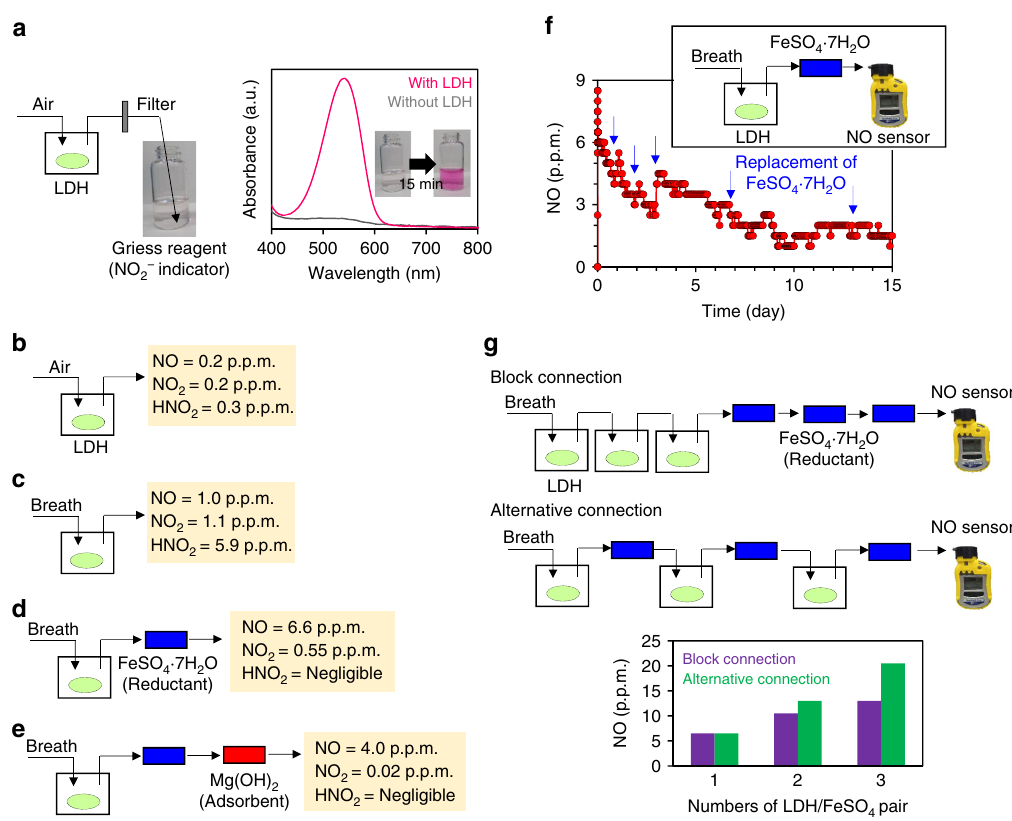
Fig. 4 Release of HNO 2 and conversion to NO. a Color change of Griess reagent showing the presence of HNO 2 . b – e Concentrations of NO, NO 2 , and HNO 2 released from 100 mg NaNO 2 -Mg/Al(3/1) (determined by detector tube). See Supplementary Fig. 3 for experimental details. Air (20 °C, 35%RH) or exhaled breath were applied at fl ow rate of 100 mL min − 1 . Released gases were passed through FeSO 4 ∙ 7H 2 O and Mg(OH) 2 loaded in the glass tube. f NO- release pro fi le from 100 mg NaNO 2 -Mg/Al(3/1) under exhaled-breath fl ow (50 mL min − 1 ). FeSO 4 ∙ 7H 2 O was occasionally replaced with new ones (indicated by blue arrow). See Supplementary Fig. 4 for experimental details. g Tandemly connected NaNO 2 -Mg/Al(3/1) and FeSO 4 ∙ 7H 2 O (in block or alternative manner) for accumulating the concentration of NO under exhaled-breath fl ow (50 mL min − 1 ). Each vial contains 100 mg NaNO 2 -Mg/Al(3/1). The NO concentration is monitored after stabilization for 15